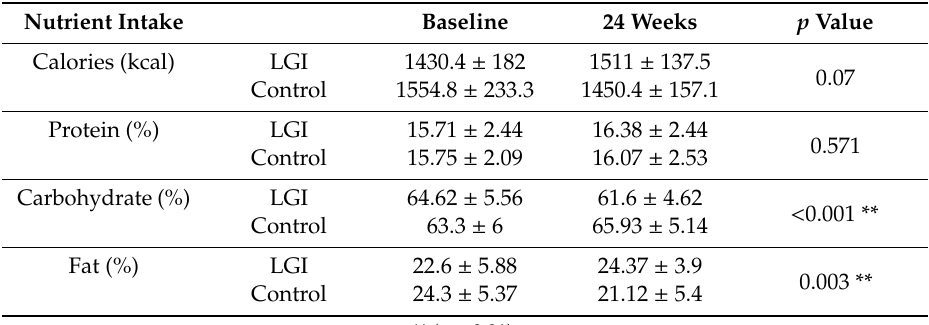
Table 5. Comparison of the percentage of the macronutrient intake between baseline and 24 weeks after dietary intervention in the study groups.